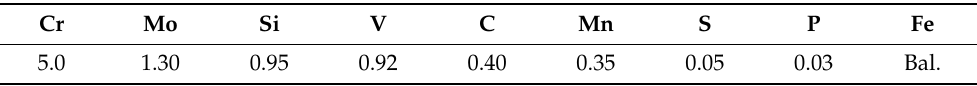
Table 1. Chemical compositions of H13 steel. (wt%).